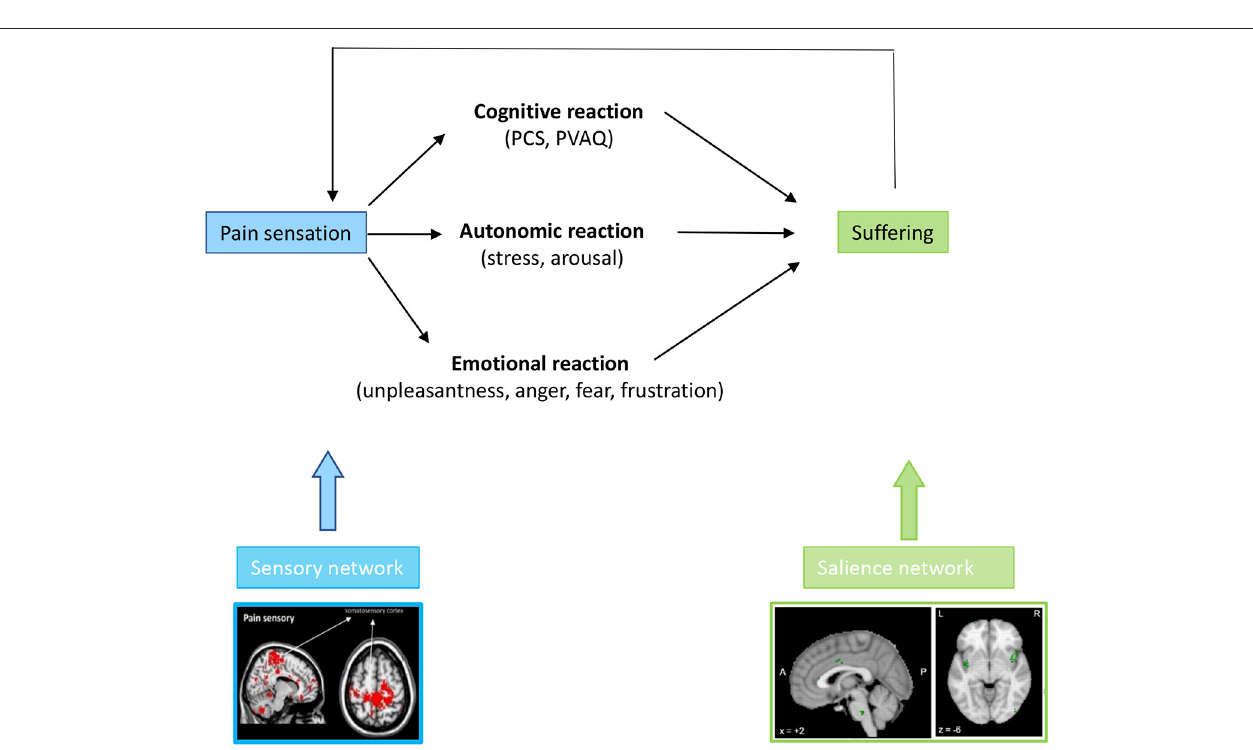
FIGURE 4 | Triple Network model. The salience and central executive networks are correlated, and both are anti-correlated to the default mode network.